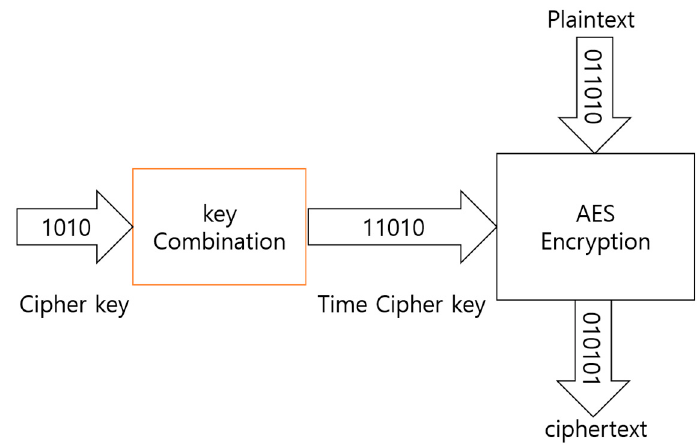
Figure 7. Overall structure of the encryption algorithm.